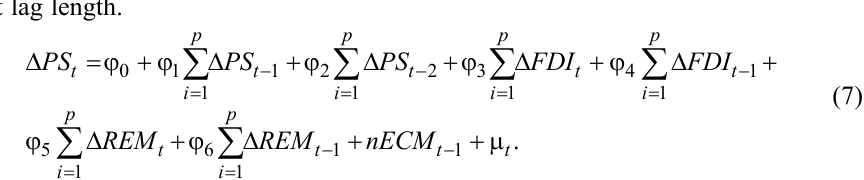
Table 6 represents the short run relationship between foreign capital inflows and pri- vate savings. Results indicate the lagged error correction term for the estimated private savings equation is both negative and statistically significant. This confirms a valid short run relationship between foreign capital inflows and private savings in Pakistan.